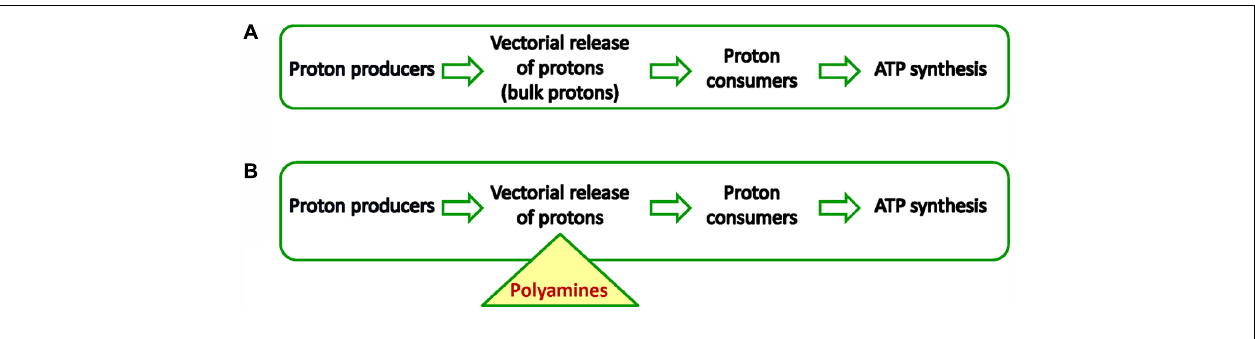
proton-driven ATPases. (B) New chemiosmosis. PAs buffer acidic compartment and energize the membrane that houses ATPases. The triangle shows the central point of the PAs role in chemiosmosis. In other words PAs act as intermediates receiving protons from producers and deliver them to